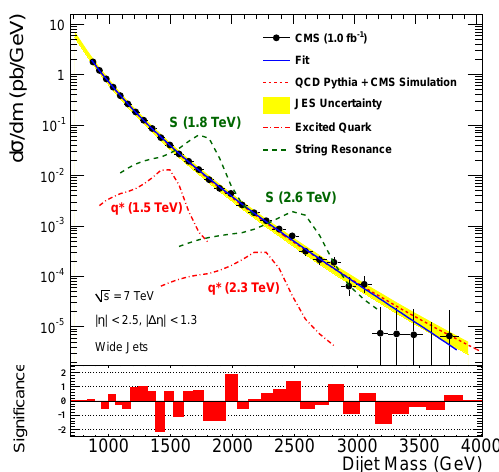
Fig. 5. Dijet mass spectrum from wide jets (points) compared to a smooth fit (solid) and to predictions including detector simula- tion of QCD (short-dashed), excited quark signals (dot-dashed), and string resonance signals (long-dashed). The QCD prediction has been normalized to the data. The error bars are statistical only. The shaded band shows the systematic uncertainty in the jet en- ergy scale (JES). The bin-by-bin significance of the data-fit dif- ference is shown at bottom.